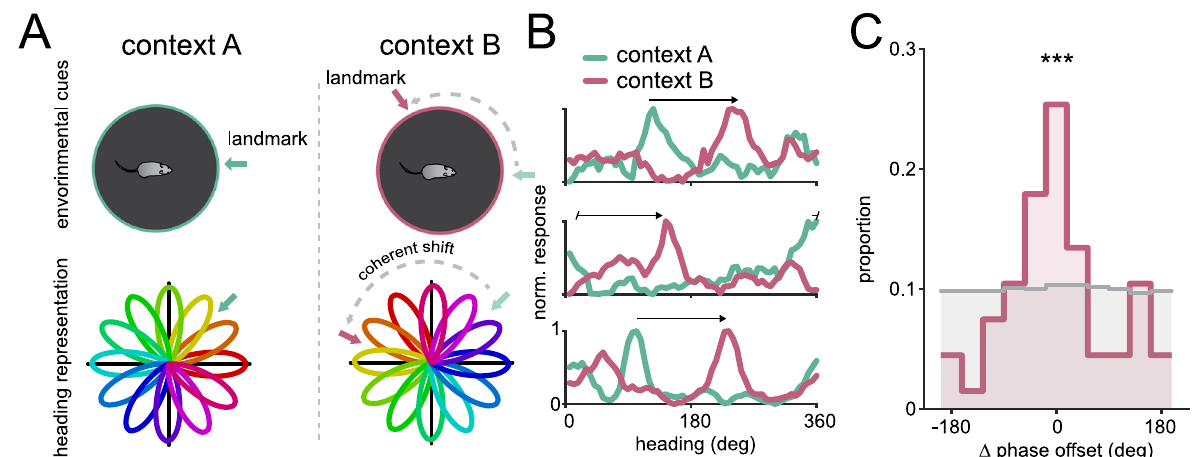
Fig. 3|Theheading network coherentlyremapswhenvisualcuesarechanged. A Schematic showing coherent remapping across two different contexts. Because each individual neuron ’ s preferred heading is mapped as a relative offset to visual landmarks, the relationships between neuron offsets would be expected to be preservedacrosscontexts,leadingtoacoherentpopulationshift. B Threeexample neurons from the same session showing a uni fi ed shift in preferred heading from contextAtocontextB.TuningcurvefromcontextAisshowningreen,whiletuning curve from context B is shown in purple. Arrow shows the phase offset between